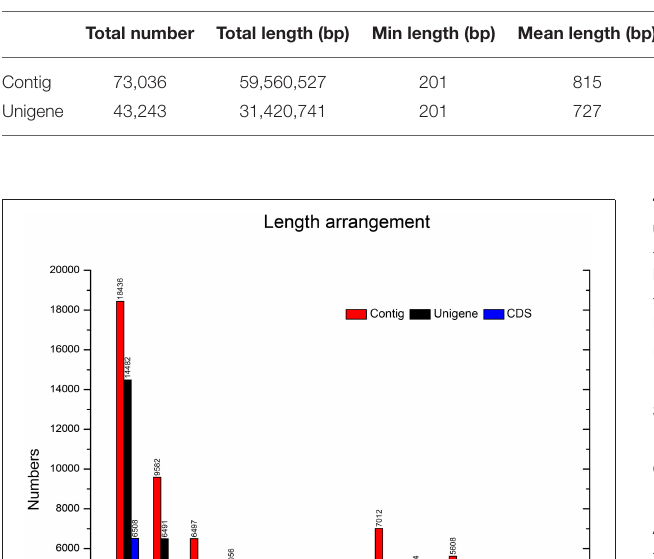
TABLE 1 | Summary of Illumina paired-end sequencing and assembly for D. asperoides.